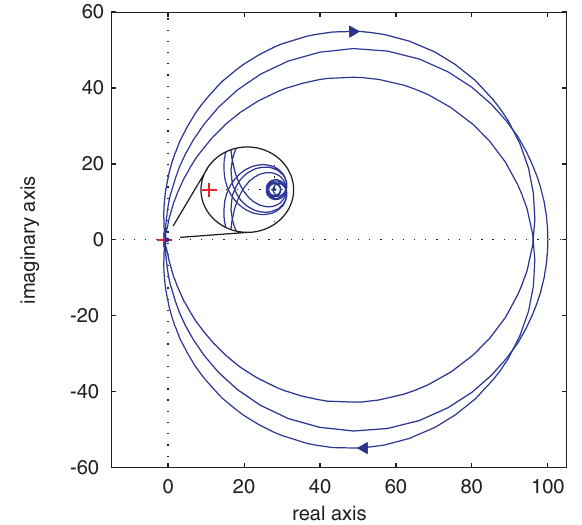
FIG. 8. (Color) Nyquist diagram for the open loop transfer function of a cavity hosting the (cid:2) -mode and 8 (cid:3) 5 : 6 (cid:1) s and G (cid:3) 100 . The circle contains a zoomed with (cid:4) loop view of the region around the origin and the point s (cid:3) (cid:4) 1 (cid:8) i 0